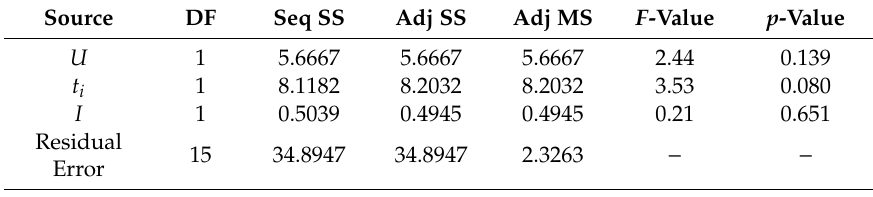
Table 9. ANOVA for linear tool wear ( TW ).